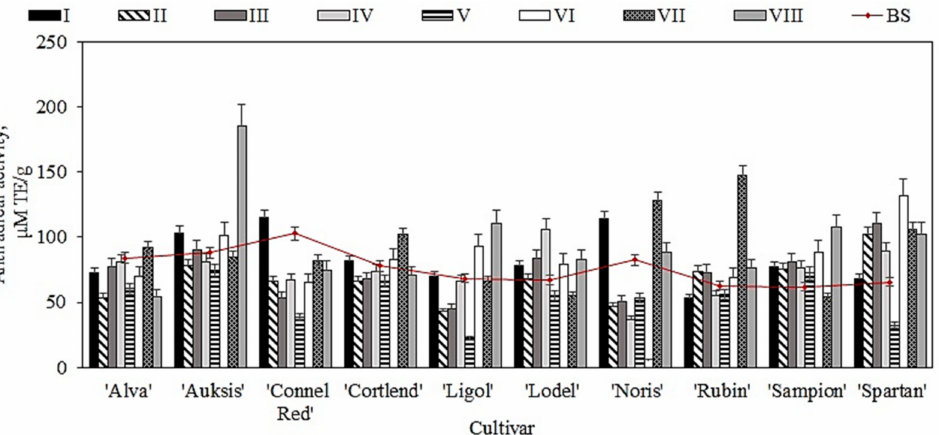
Figure 8. Antioxidant activity of whole apple samples before and after storage in controlled atmo- sphere evaluated via the DPPH free radical scavenging